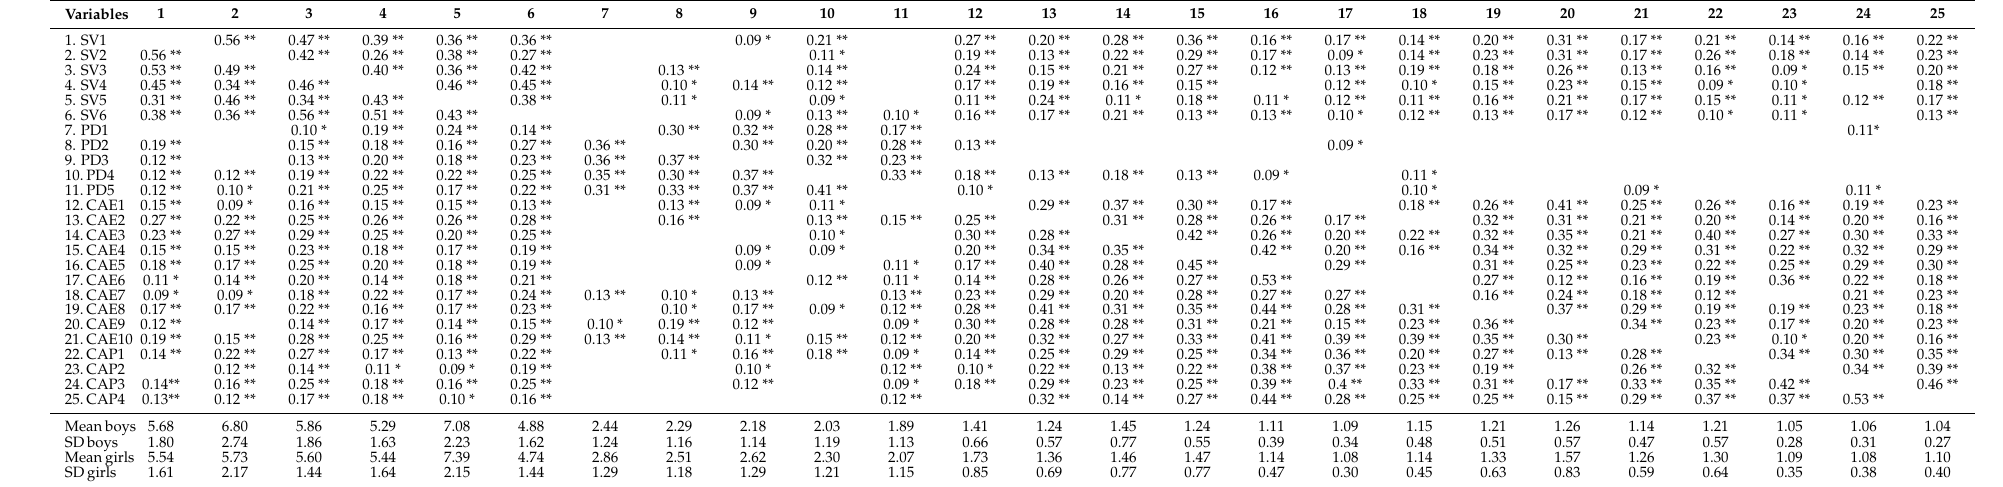
Table 2. Spearman significant correlations and descriptive statistics for observable variables for girls (top right) and boys (bottom